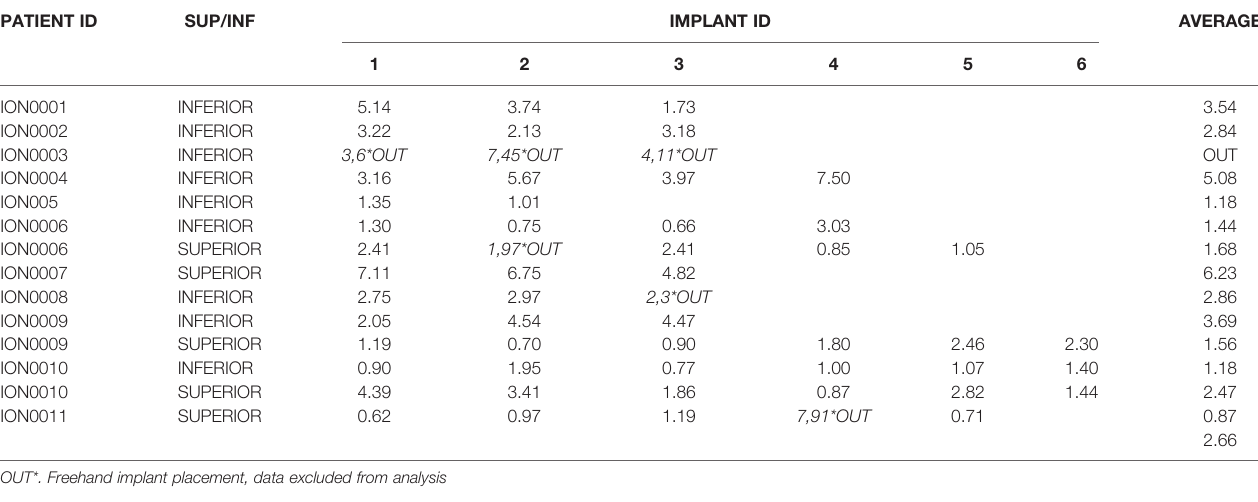
TABLE 3 | Results of the end point deviation in mm.